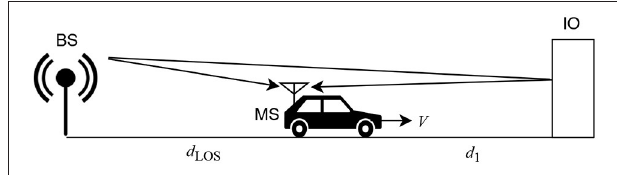
FIGURE 1 | Two-ray propagation model with a mobile station and an IO creating